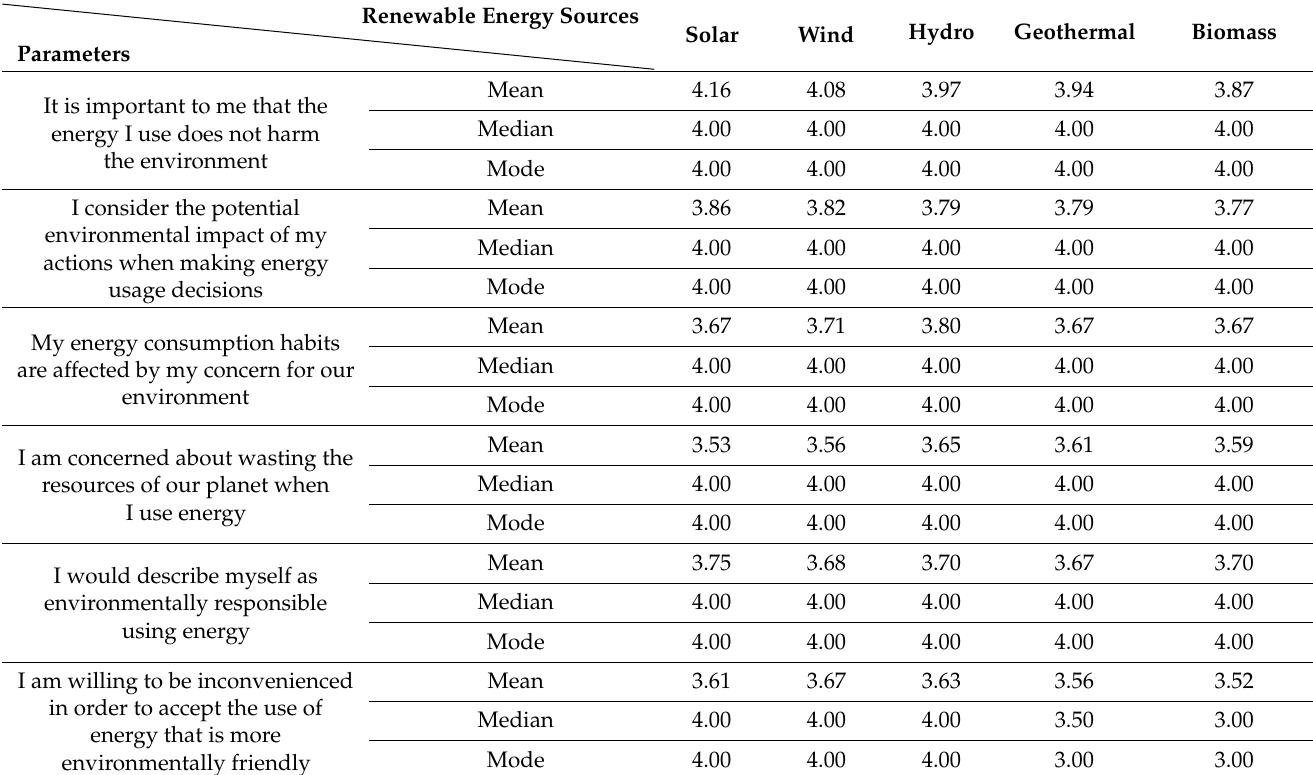
Table 4. Mean, median, and mode GREEN consumer values for renewable energy